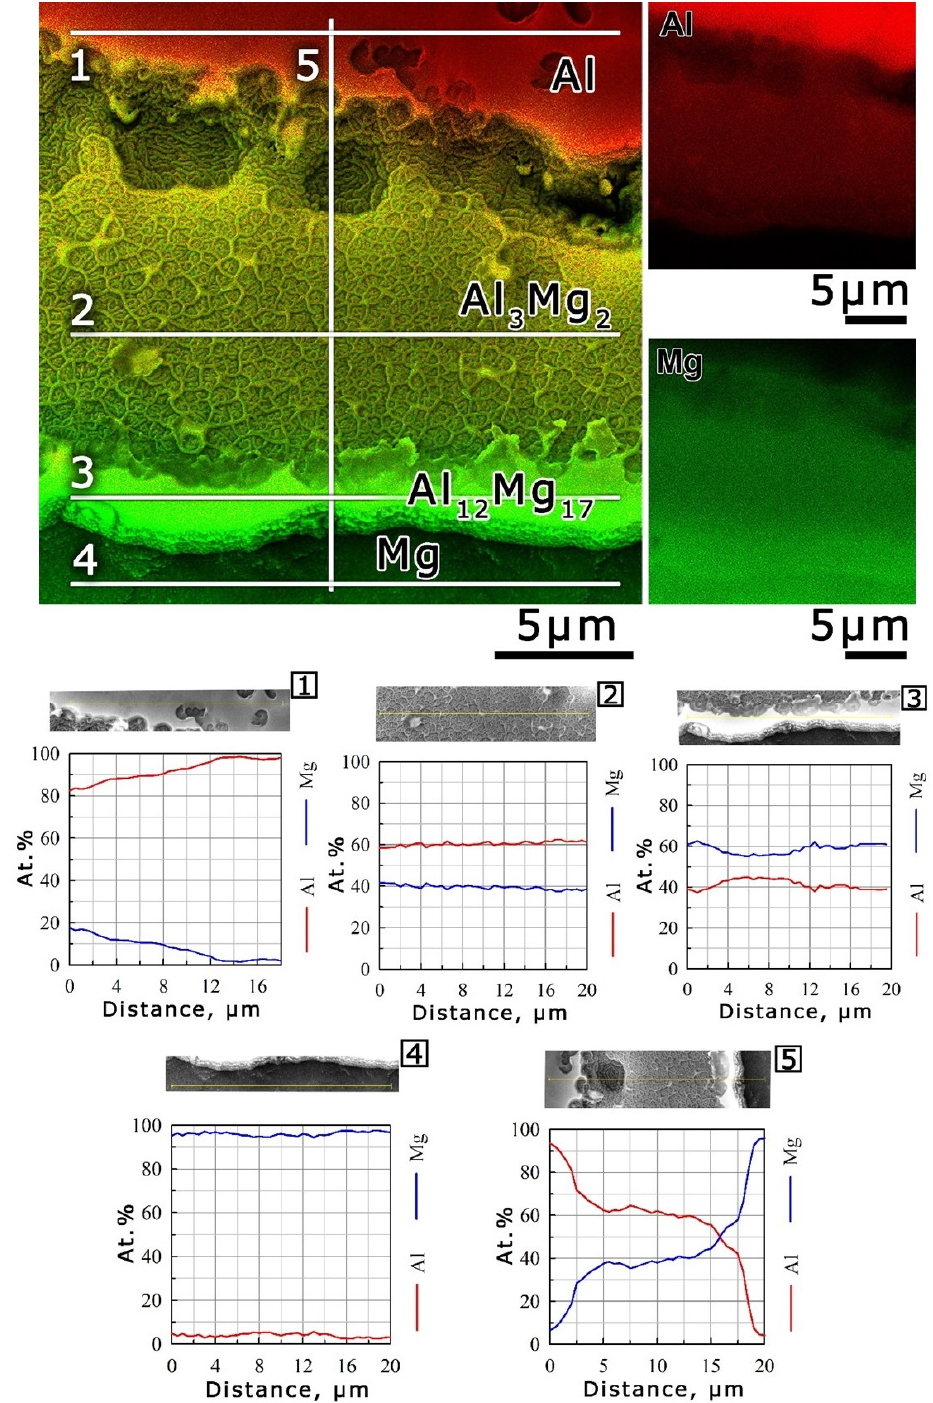
Figure 5. SEM image combined with an elemental map of the Al (in red) and Mg (in green). The element composition is shown along lines 1–5 at the top of the panel in the form of a relative intensity plot in relation to the scanning distance of the Al and Mg, marked in red and blue, respectively.